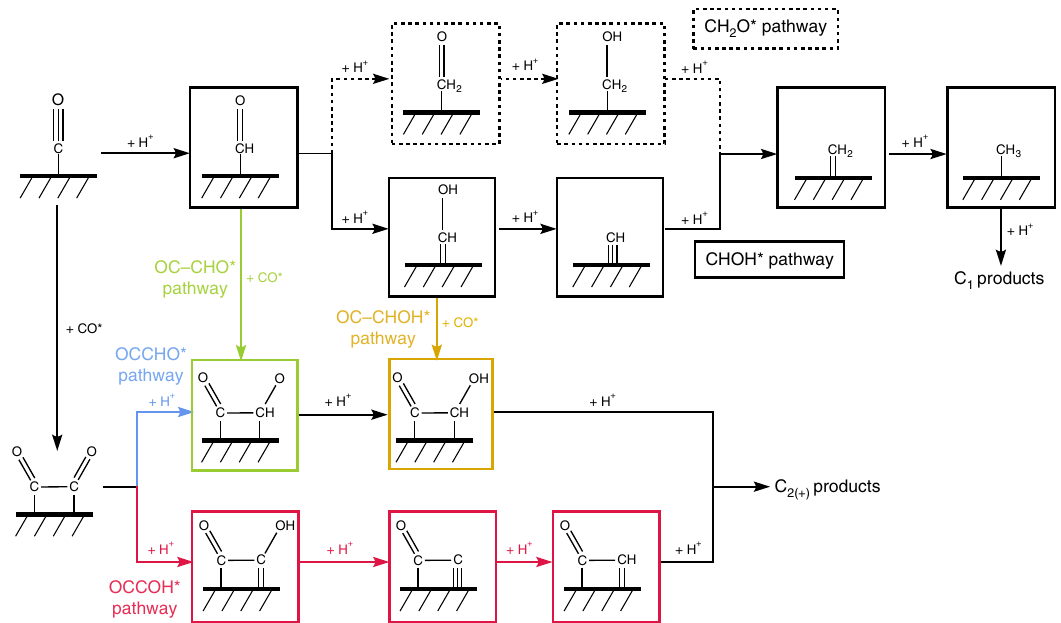
Fig. 1 Reaction schemes of major pathways considered for CO reduction toward C 1 and C 2 + products. The green path denotes C 2 production via OC – CHO coupling; the blue and red path represents C 2 production via protonation of OCCO to form OCCHO and OCCOH, respectively; the yellow path represents C 2 production via OC – CHOH coupling. The black path denotes C 1 production via CHOH and the dashed CH 2